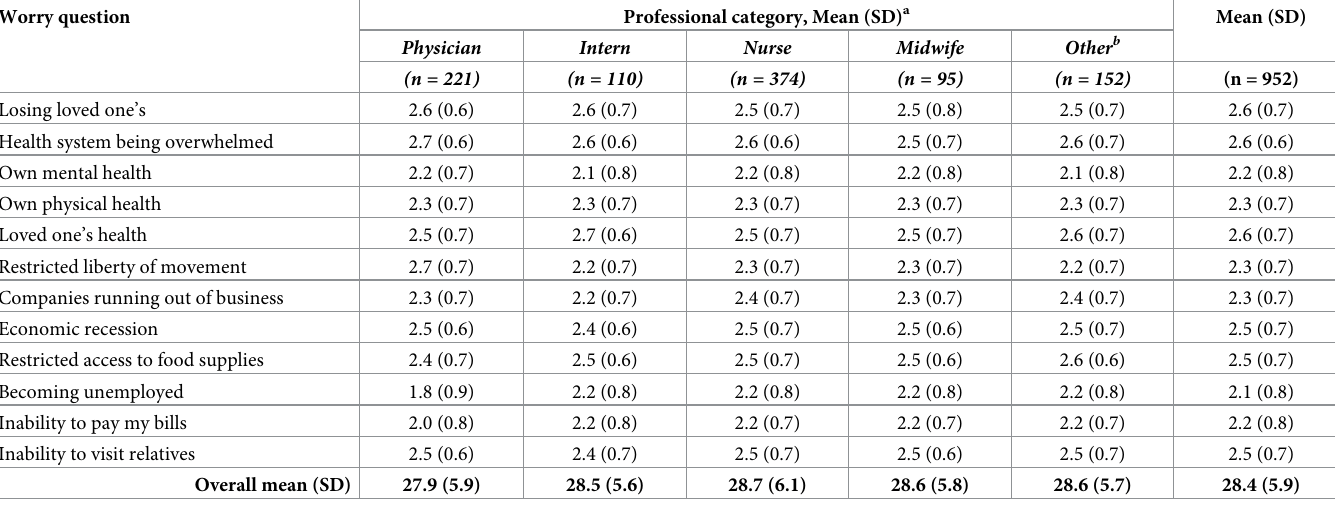
Table 5. Mean worry score of healthcare professionals about COVID-19 crisis by professional category (N = 12